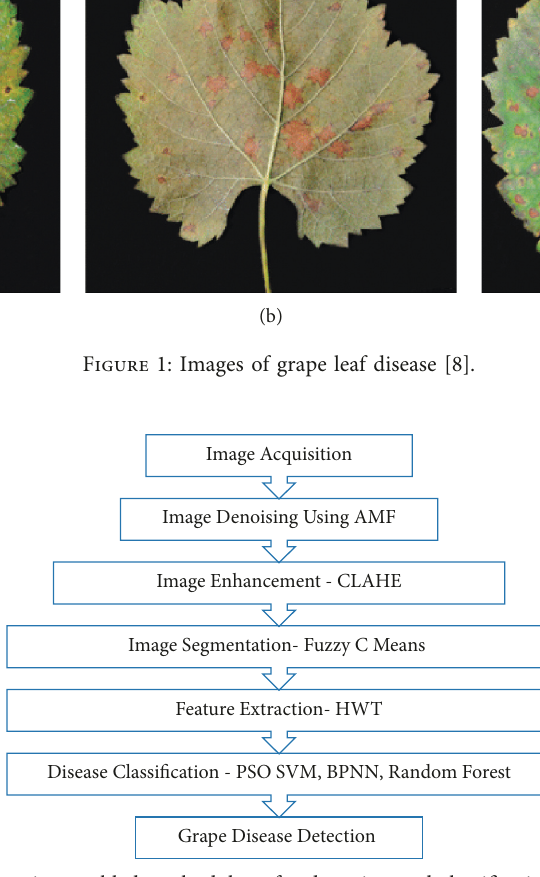
Figure 2: Image processing-enabled methodology for detection and classification of grape leaf disease.